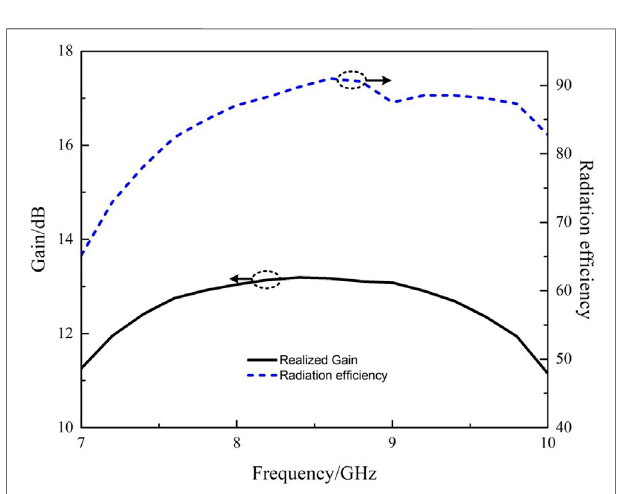
FIGURE 10 | Realized gain and radiation ef fi